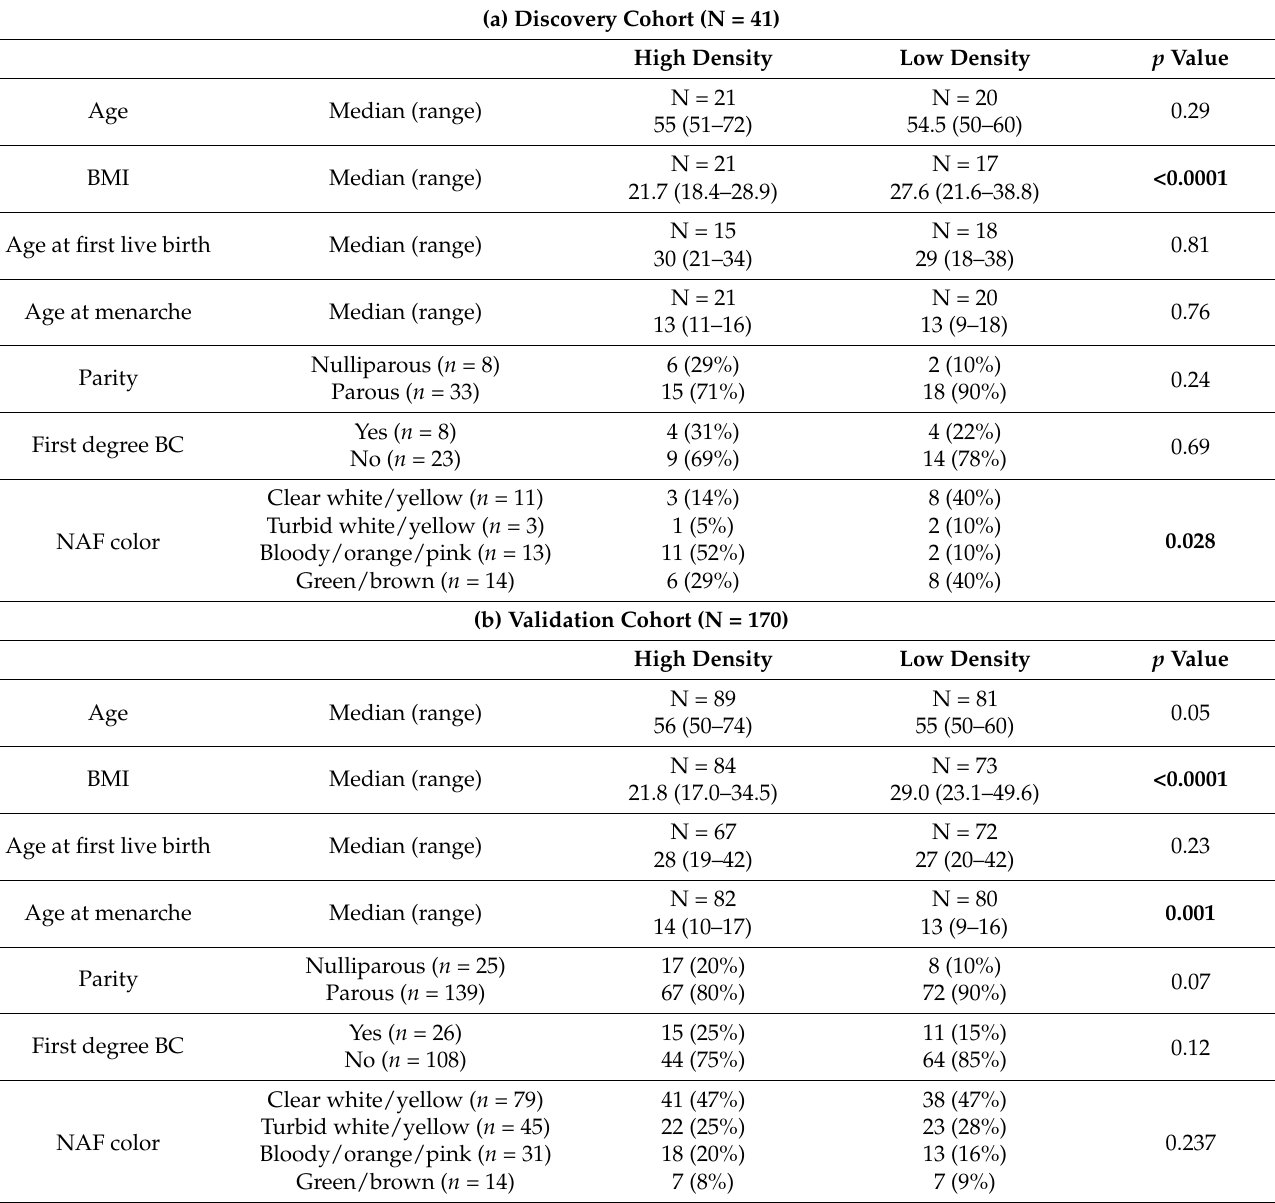
Table 1. Baseline characteristics of extremely high (“high”) and very low (“low”) mammographic density cohorts. ( a ) Discovery cohort and ( b ) validation cohort. Cohort size per baseline characteristic can differ due to missing values. Bold p- values indicate significant difference.